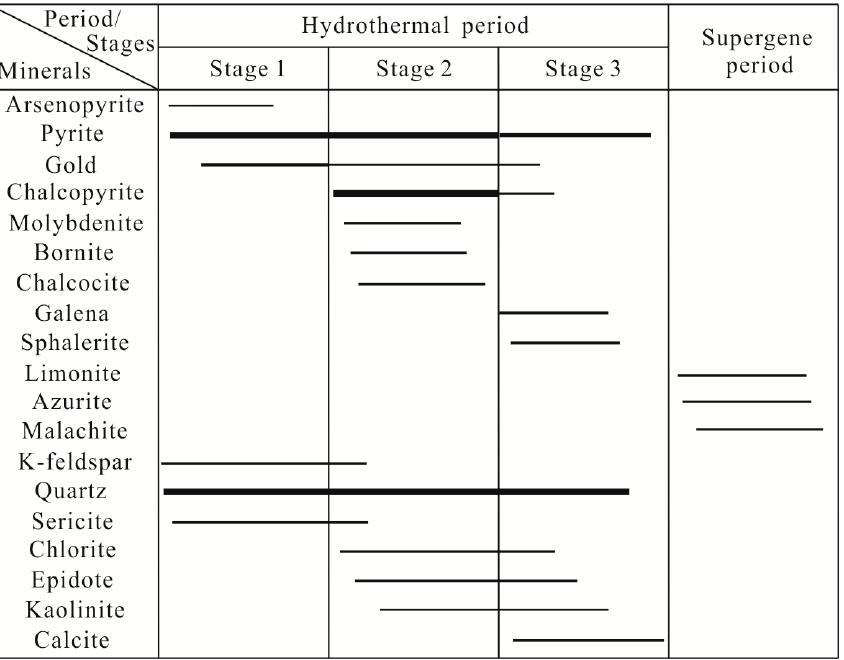
Figure 6. Mineral paragenesis for the Jinchang deposit.